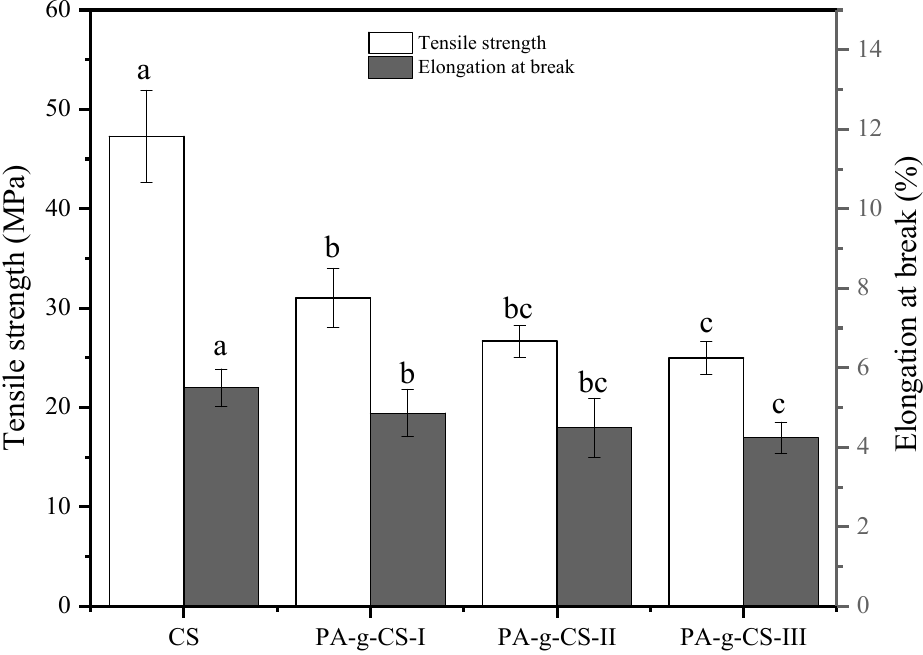
Figure 6. Tensile strength and elongation at break of the CS and PA-g-CS (I-III) films. Different letters in the same index indicate a significant difference (p < 0.05).